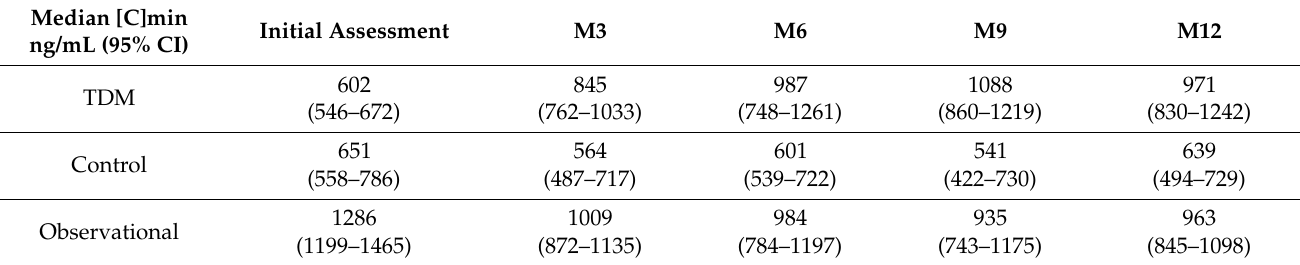
Table 2. Pharmacokinetic results during the 12 months follow-up of the OPTIM imatinib